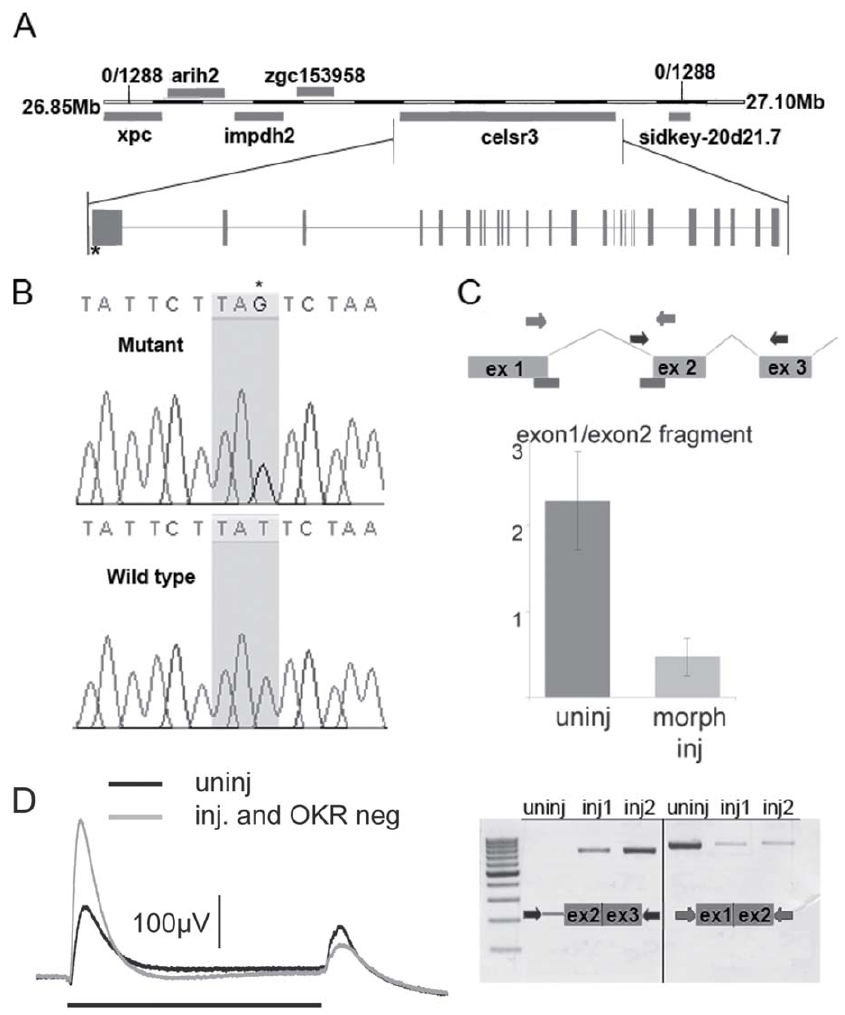
Figure 3. zvm7 w65 has a mutation in celsr3 gene. A) A diagram of the genetic locus of celsr3 . B) The zvm7 w65 fish have a mutation in celsr3 that creates a stop codon at nt postion 651 of exon1. C) A diagram of predicted morpholino interaction sites (bars). Injection of splice site morpholinos results in abnormal splicing of celsr3 mRNA. Levels of correctly spliced celsr3 were determined using primers to exon1 and exon2 in a qPCR rxn (middle panel) and by agarose gel electrophoresis (bottom panel right side). Incorrect splicing can be seen in morpholino injected (inj) animals using primers in intron 1 and exon3, which do not give a product in the uninjected (uninj) animals (left bottom panel). D) Morpholino injected zvm7 w65 heterozygotes that are OKR-negative have an increased b-wave (n=4) compared to uninjected siblings. Black bar indicates 3 sec. light